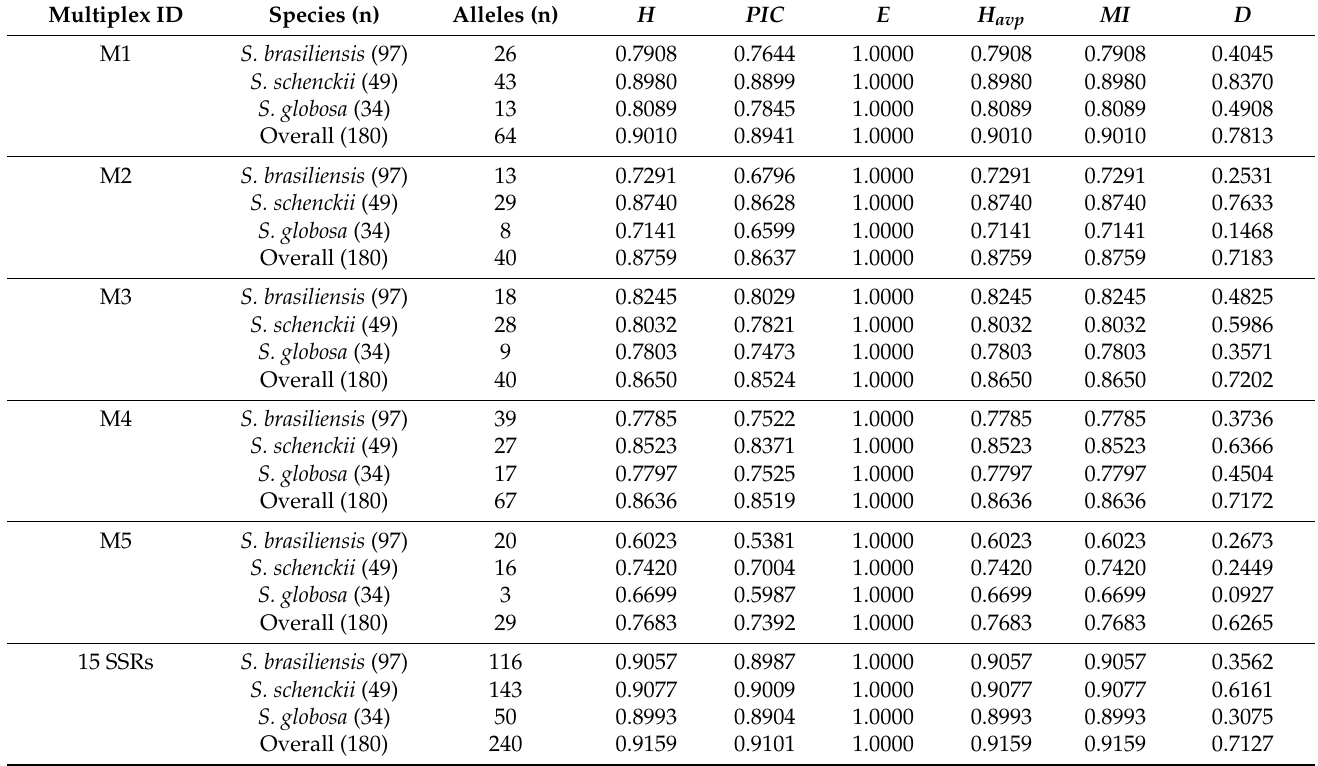
Table 3. Polymorphic statistics for multiplexes M1–M5 of SSR markers in Sporothrix